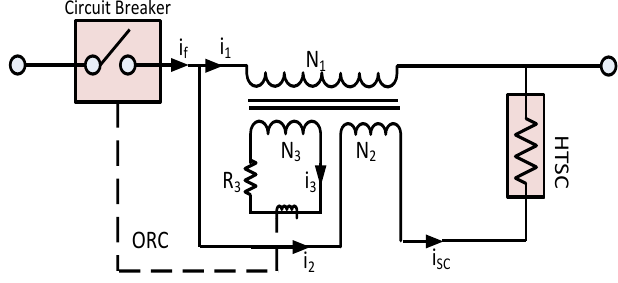
Figure 7. Configuration of the flux-lock type SFCL.